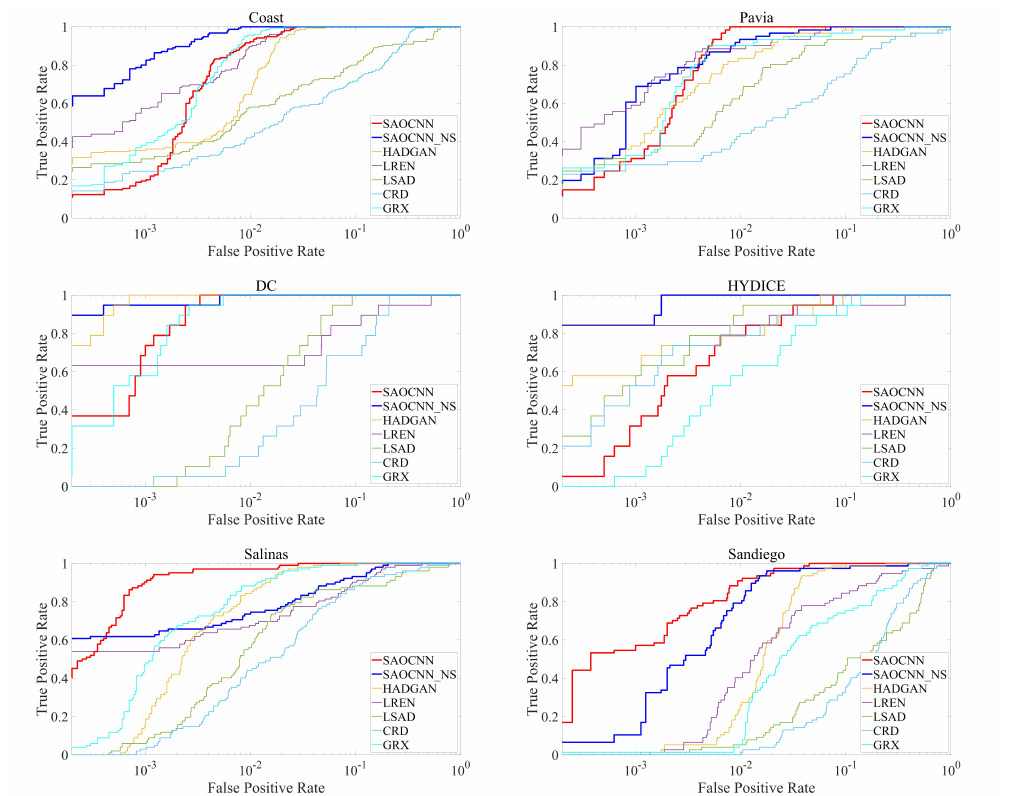
Figure 7. ROC of ( P d , P f ) for SAOCNN, SAOCNN_NS, HADGAN, LREN, LSAD, CRD, and GRX.